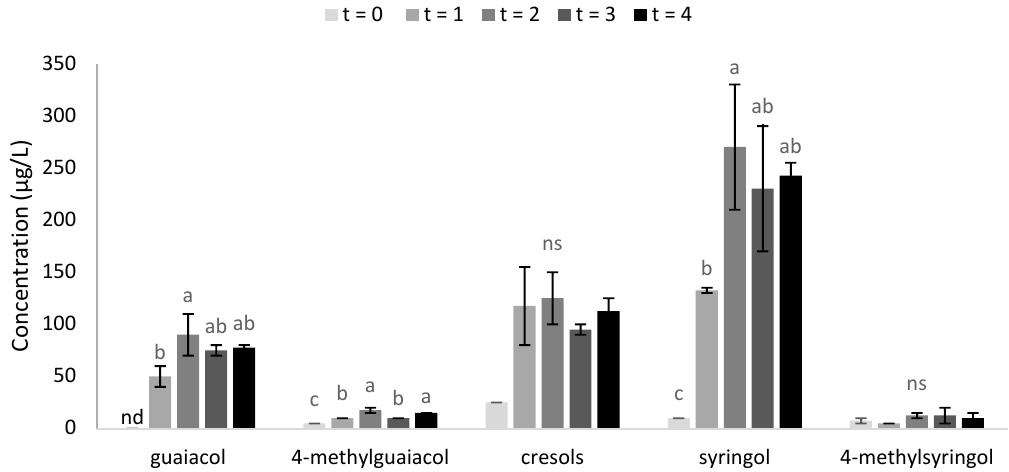
Figure 1. Volatile phenol concentrations in acid hydrolysates derived from HS grapes sampled at di ff erent time points, i.e., immediately prior to smoke exposure (t = 0); 1 h after smoke exposure (t = 1); 1 day after smoke exposure (t = 2); 7 days after smoke exposure (t = 3); and 4 weeks after smoke exposure (t = 4) being maturity. Values are means of two replicates ( n = 2) ± standard errors. Di ff erent letters indicate statistical significance ( P = 0.05, one-way ANOVA); ns = not significant; nd = not detected.